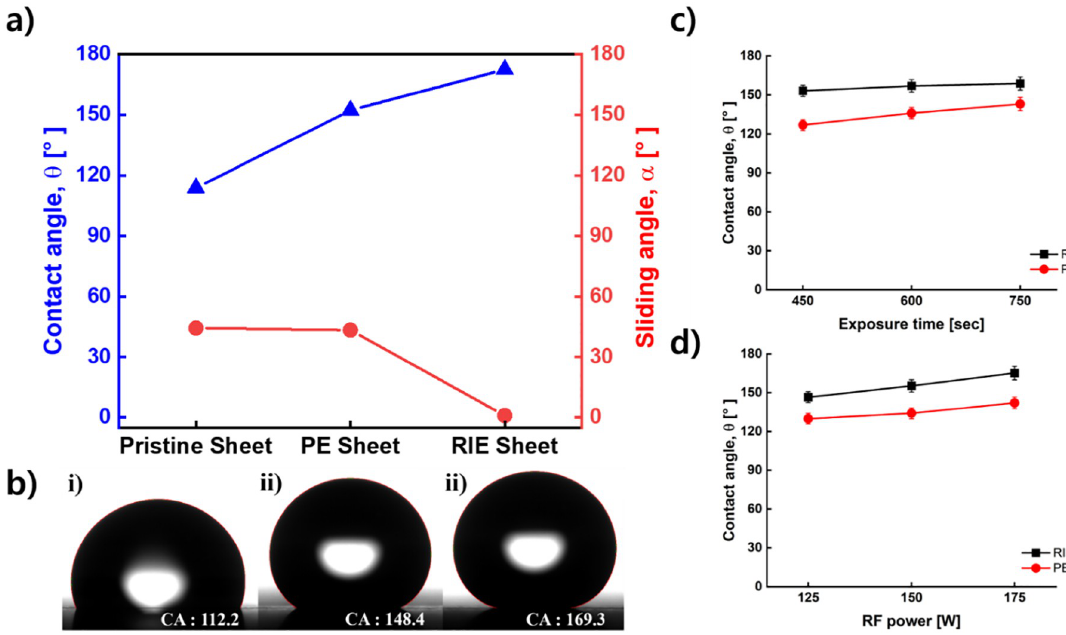
Fig 2. Graph of contact angle and change of contact angle according to slide angle and surface treatment parameters of treated specimen. (a) contact angle and sliding angle graph of before and after treatment (b) i) Before treatment, ii) After PE treatment, iii) After RIE treatment, the image where the droplet is located and the contact angle. (c, d) The contact angle graph according to the surface treatment parameter (RF power, exposure time). The PE-treated specimen is expressed in red and the RIE-treated specimen is expressed in